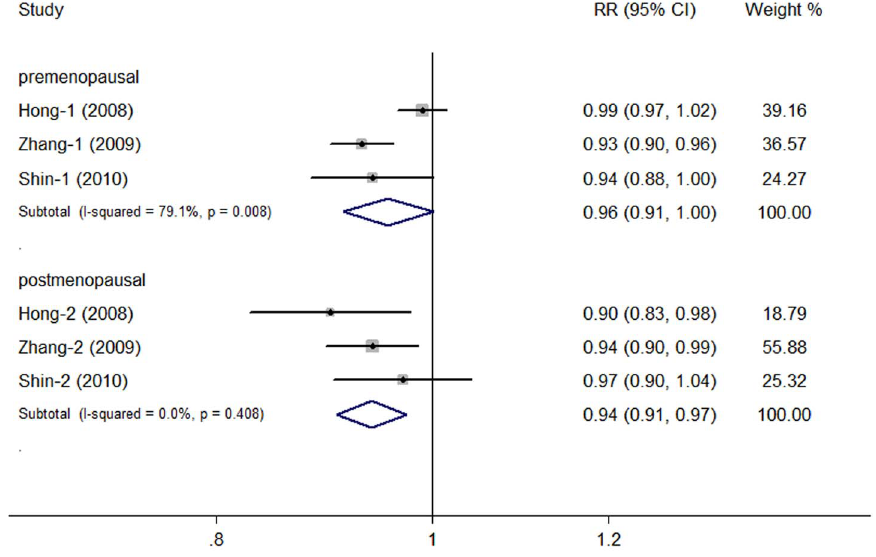
Figure 4. Dose-response meta-analyses for premenopausal and postmenopausal women.